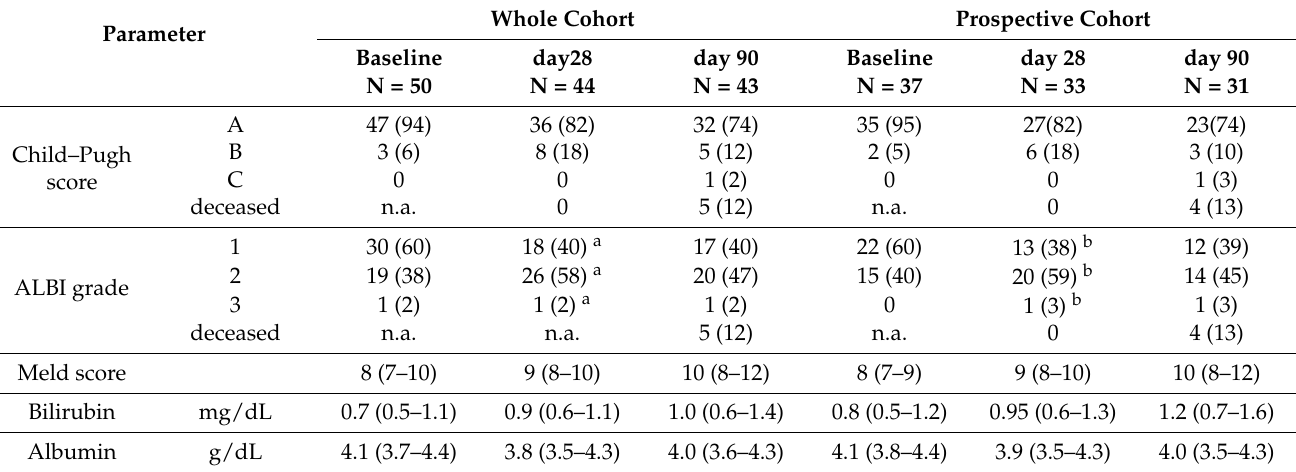
Table 2. Liver function at baseline, day 28 and day 90.